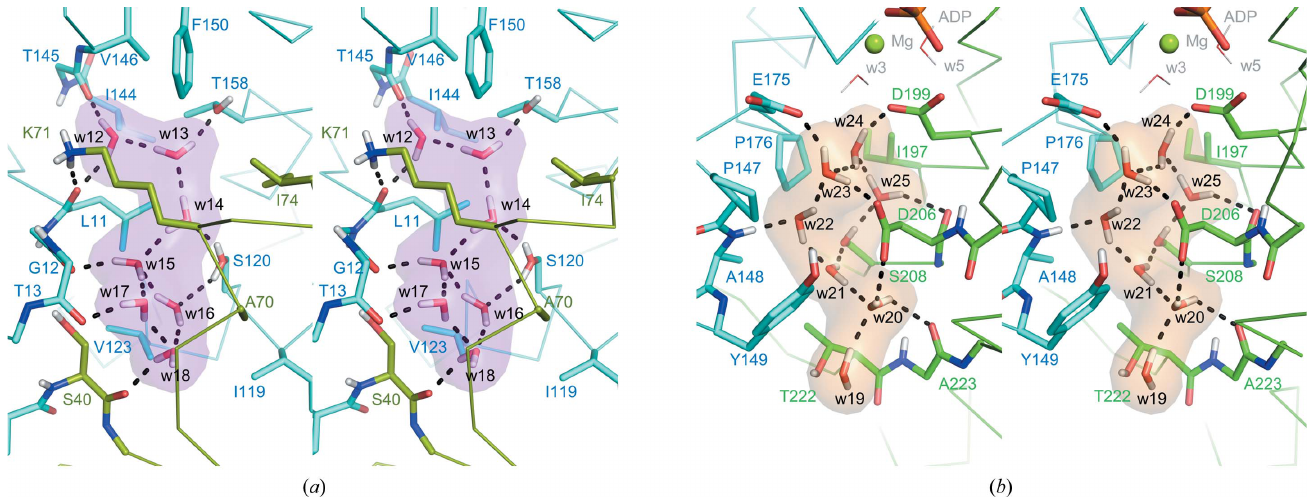
Figure 4 Wall-eyed illustration of the hydrogen-bond networks of ( a ) water cluster 2 (w12–w18) and ( b ) water cluster 3 (w19–w25) (PDB entry 7f4x). The colour scheme is the same as in Figs. 2 and